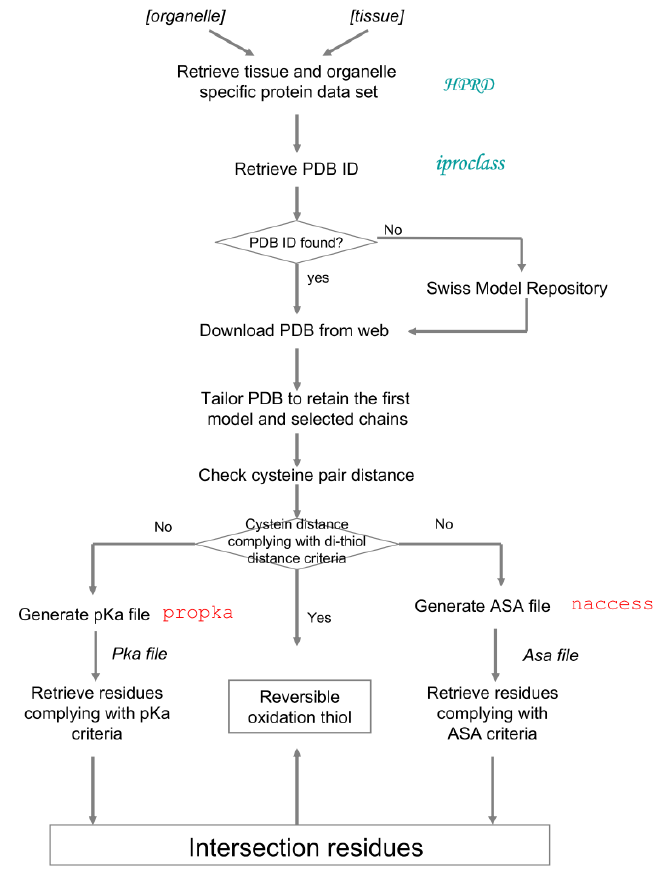
Fig. 2: The algorithm to predict protein with reversibly oxidized cysteinyl residues. The blue color denotes the database, and red denotes another standalone